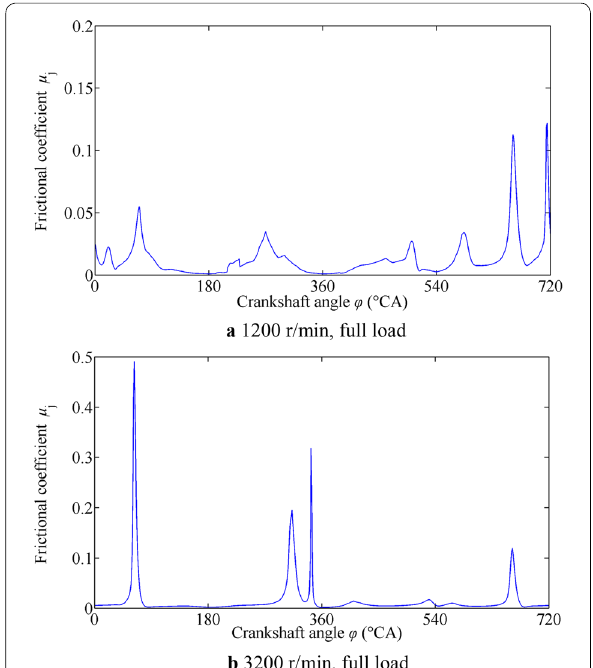
Figure 14 Frictional coefficient of No. 2 main